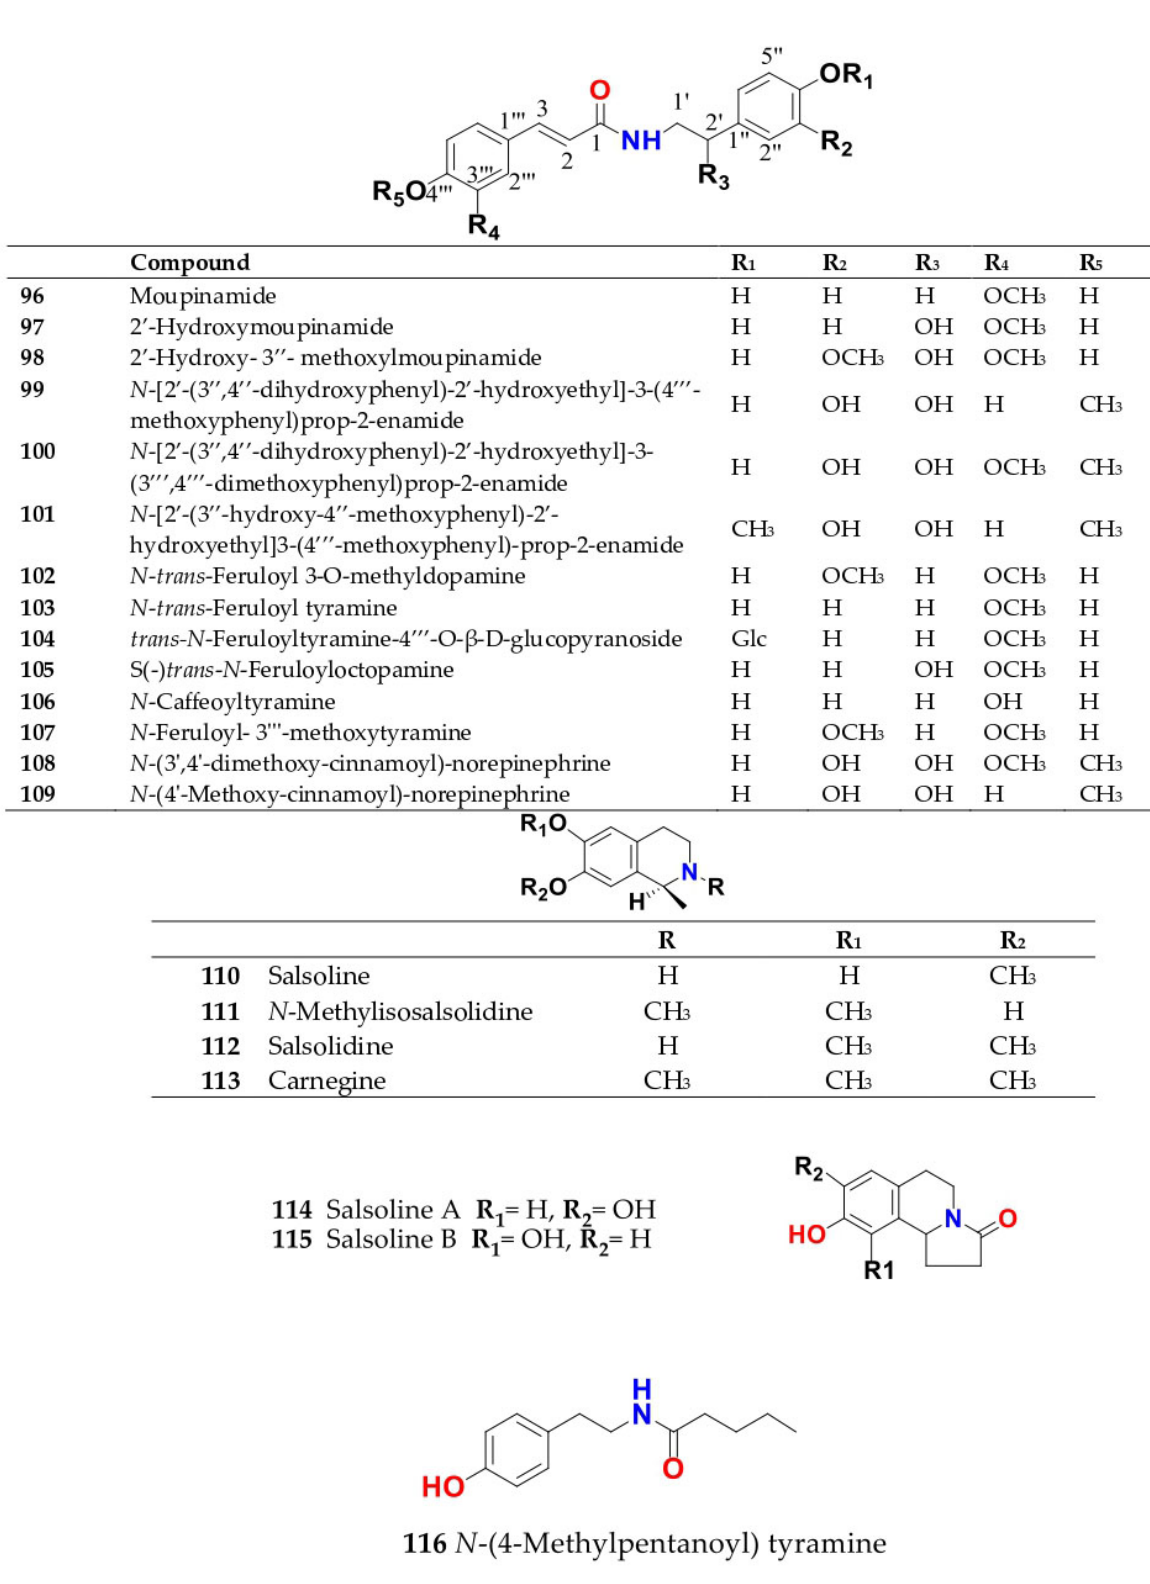
Figure 8. Chemical structure of nitrogenous compounds ( 96 – 116 ) isolated from genus Salsola.